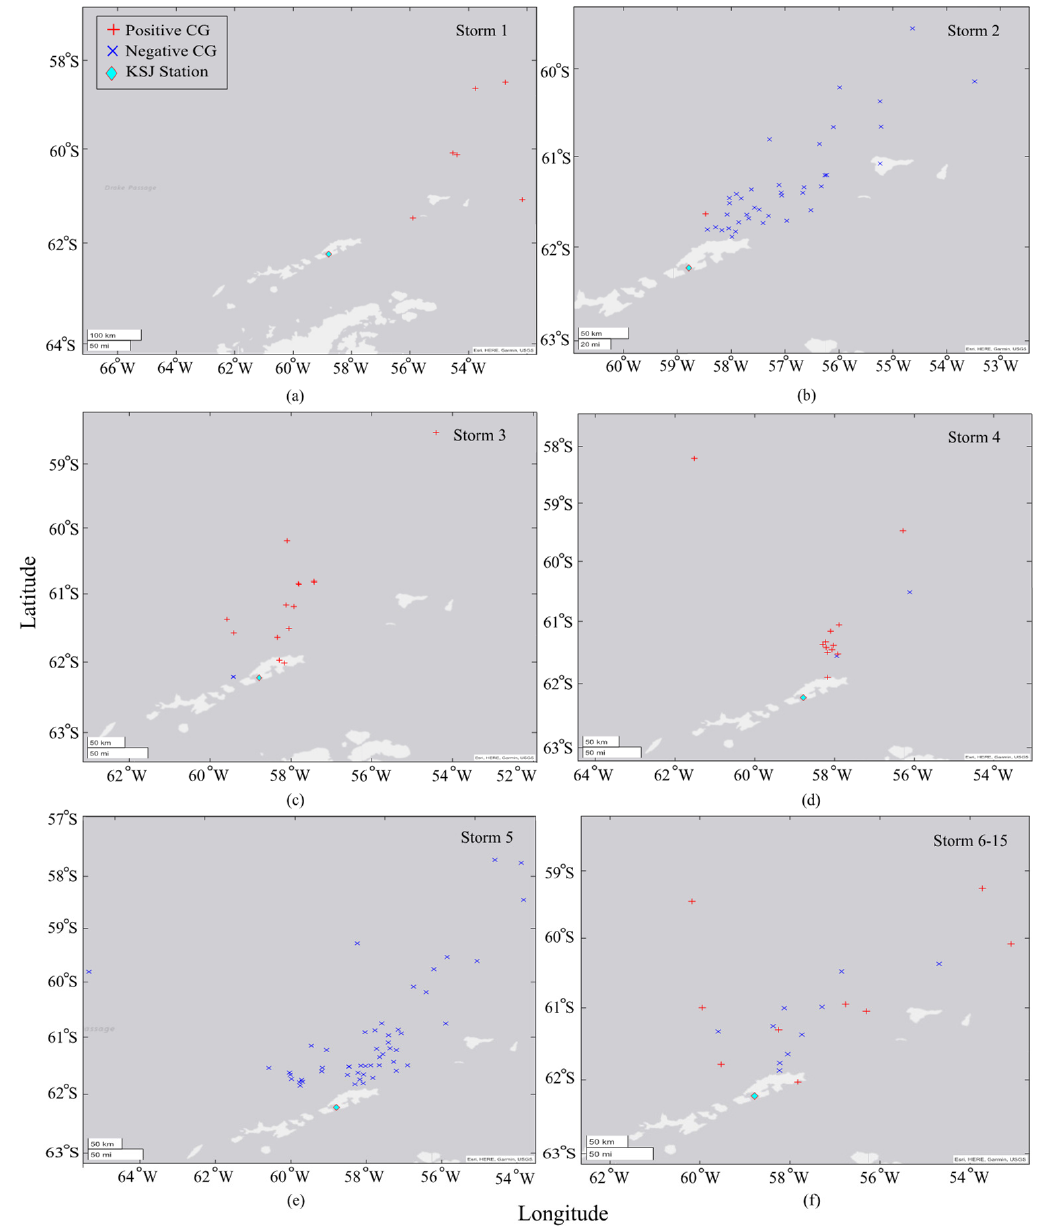
Figure 4. Individual storms occurring on different days throughout the month of January 2020.